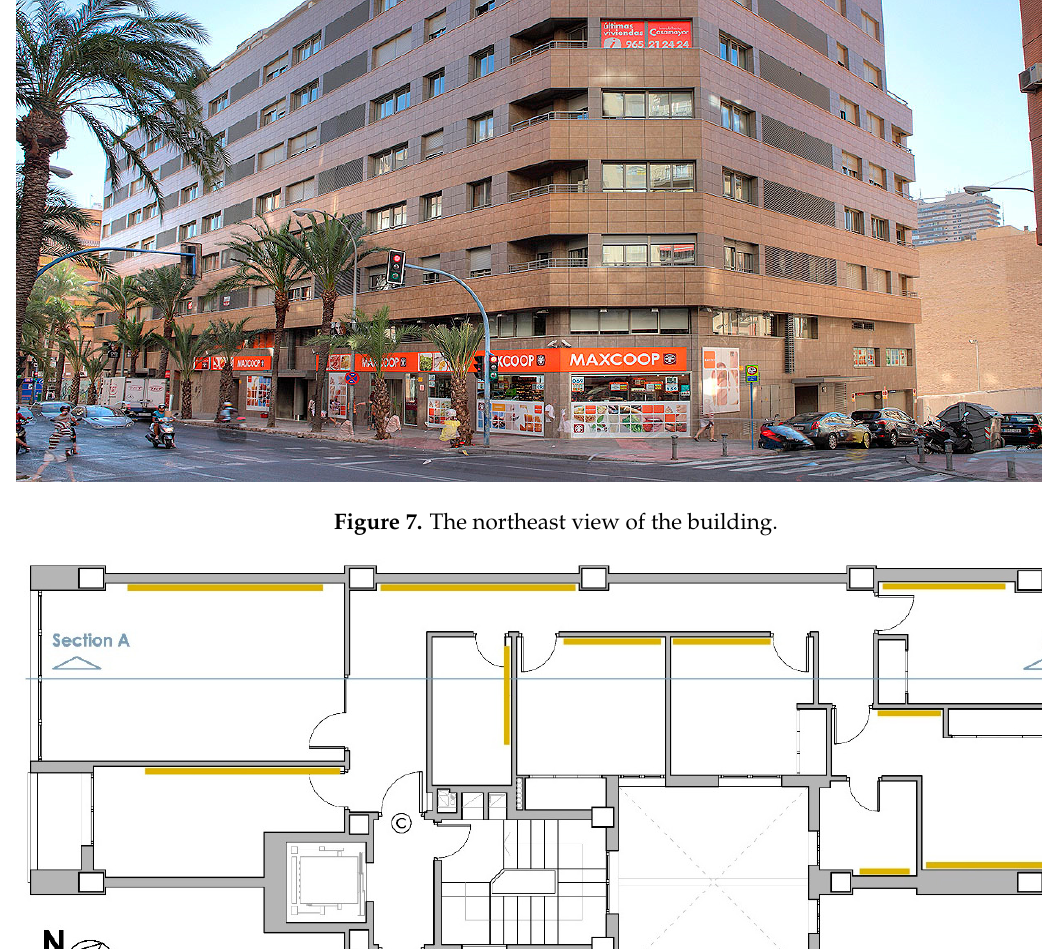
Figure 8. The general floor view of a type C flat. Thermal ceramic panels (TCP) in yellow.